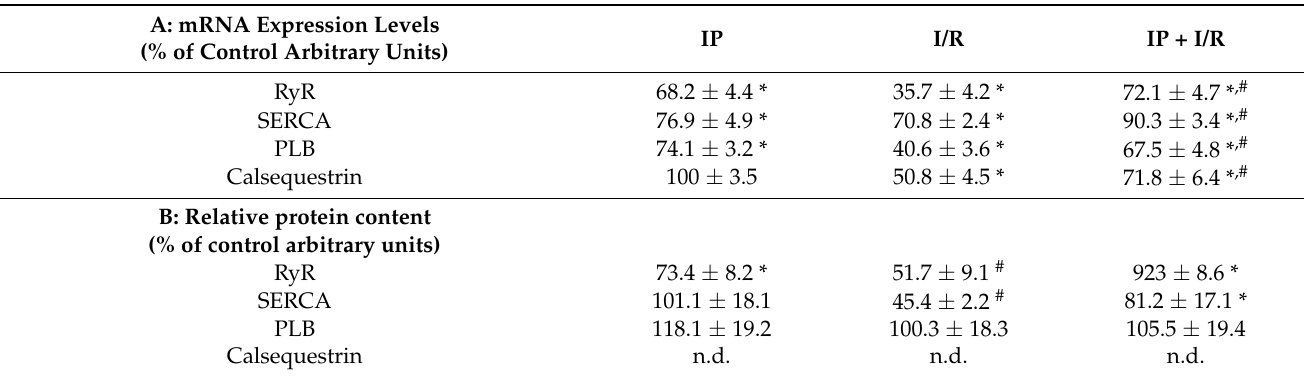
Table 3. Effect of ischemic preconditioning on SR gene expression and relative protein contents in the I–R hearts.